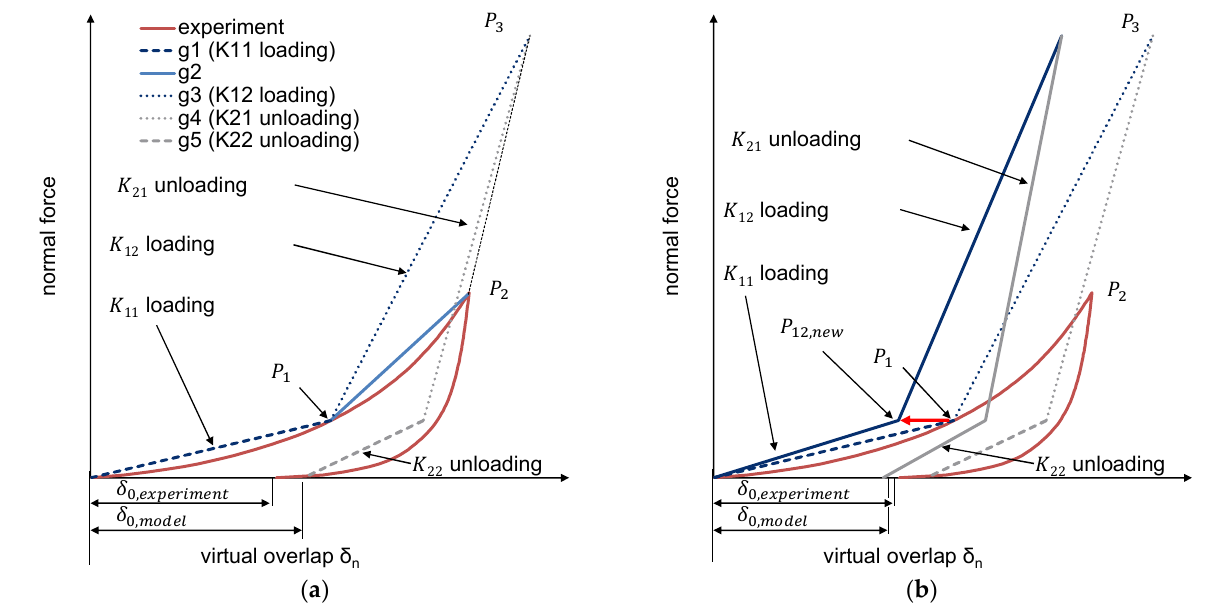
Figure 13. Contact model development. ( a ) starting point ( b ) shift The ratio of the stiffnesses K 11 and K 12 is kept constant during the iteration. Due to the simulation time, the iterations are performed solely for modeling the particles as spheres. The obtained contact models for the particular bulk material are used for super- quadrics as well. The iteration starting values and the selected stiffnesses are listed in Ap- pendix B (Table A1).